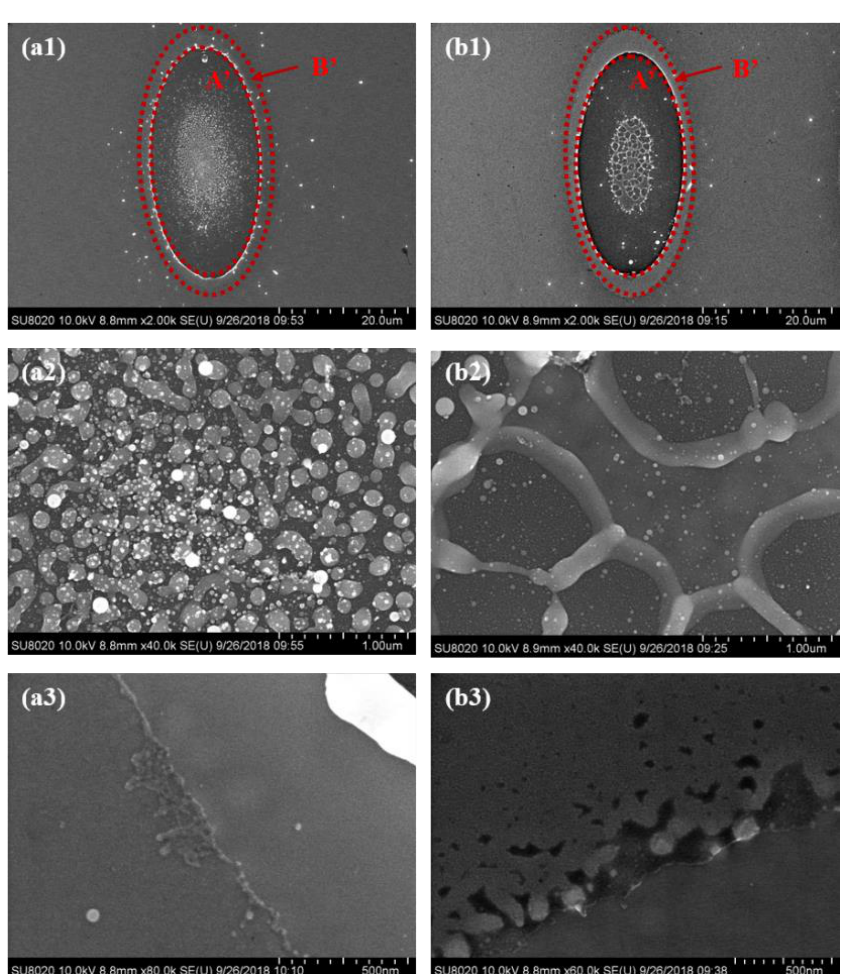
Figure 5. ( a1 ) SEM image of the pure GST film after the reflective-type pump-probe experiments, ( a2 ) SEM image of the pure GST in Zone A’, ( a3 ) SEM image of the pure GST in Zone B’, ( b1 ) SEM image of the N-doped GST film after the reflective-type pump-probe experiments, ( b2 ) SEM image of the N-doped in Zone A’, and ( b3 ) SEM image of the N-doped in Zone B’.